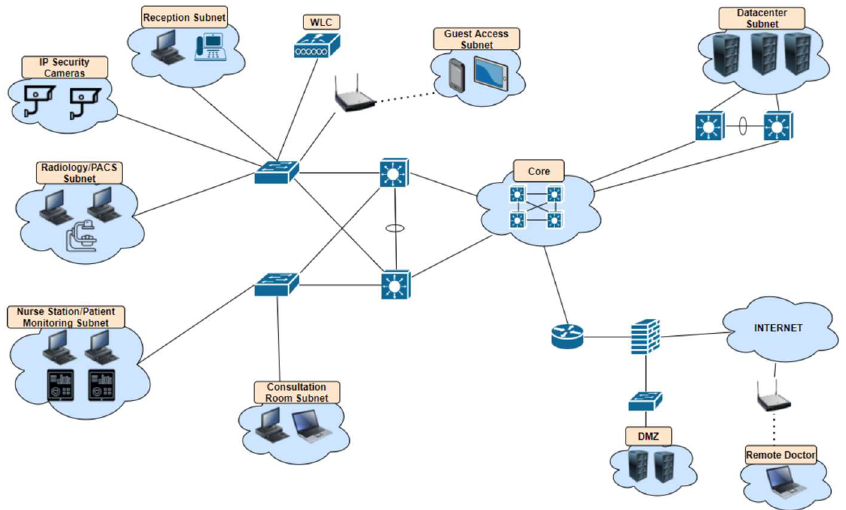
Figure 3. Physical rooms and devices contained in these rooms within the hypothetical healthcare organisation.